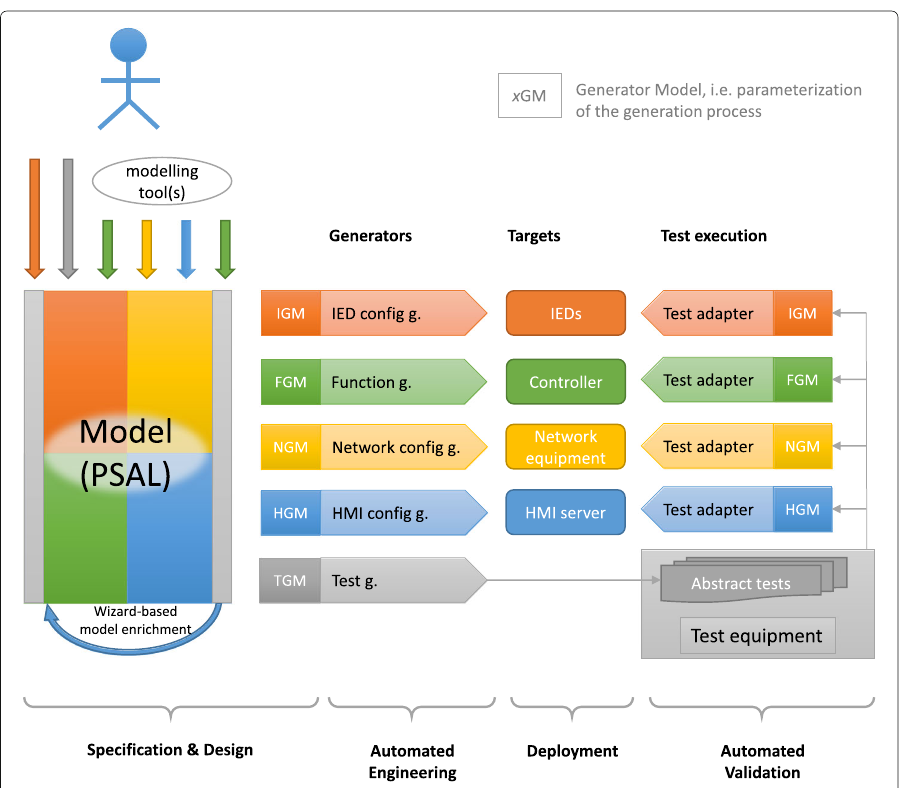
Fig. 3 Overview of the automated engineering and validation